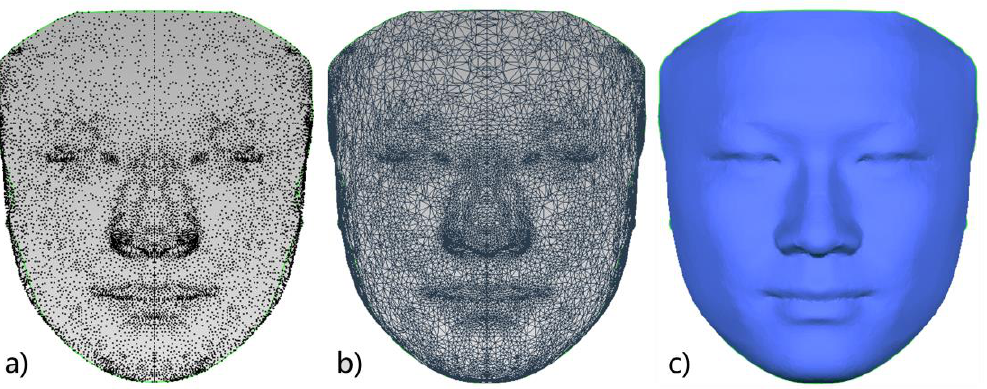
Figure 2. Three-dimensional face template: ( a ) 3D face template in point cloud form; ( b ) 3D face template in triangular mesh form; ( c ) 3D face template in smooth surface form.